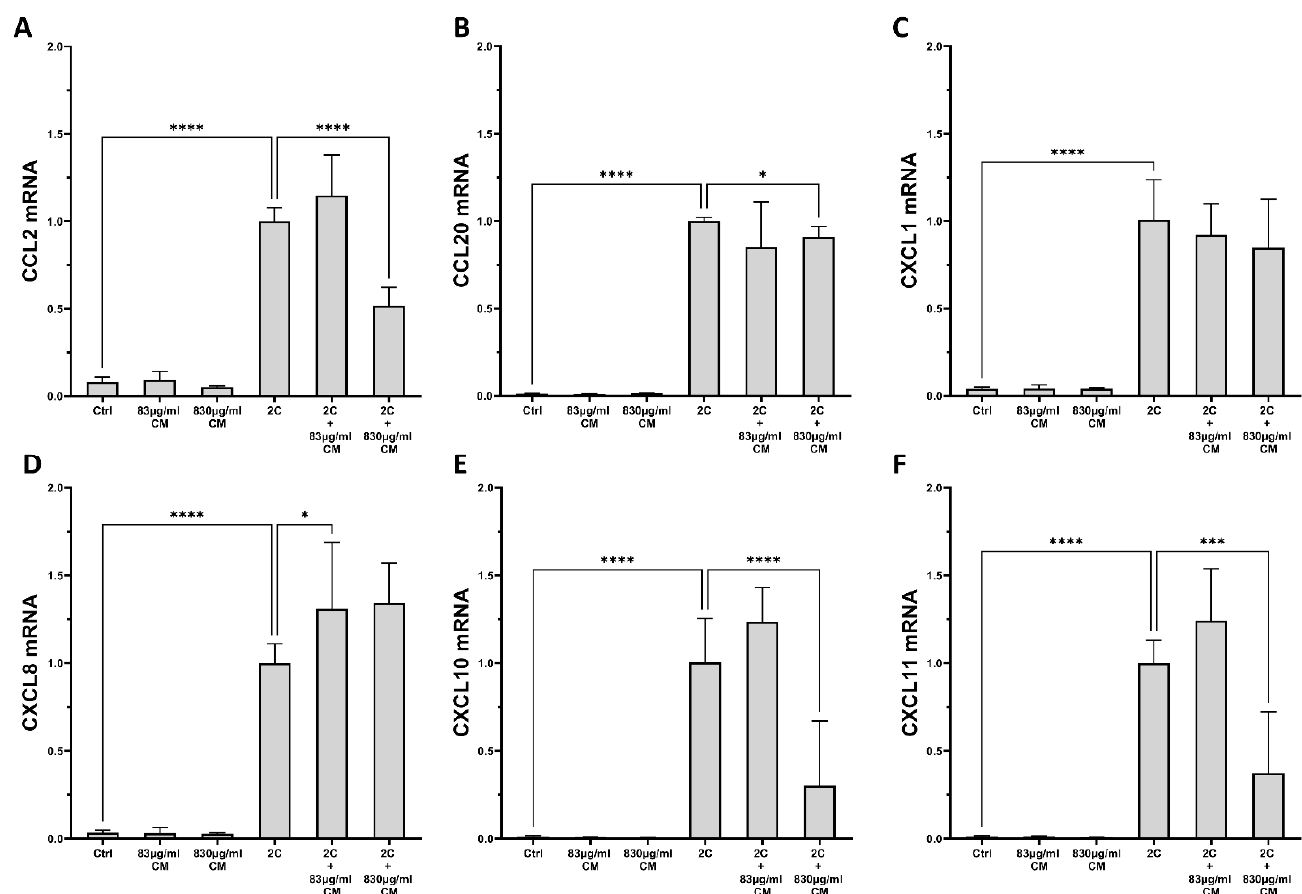
Figure 1. The effect of CM on chemokine mRNA expression in A549 pulmonary epithelial cells, which are under pro-inflammatory stimuli. CM inhibit the mRNA expression of chemokines CCL2 ( A ), CCL20 ( B ), CXCL10 ( E ) and CXCL11 ( F ) in a dose-dependent way, but have no effect on the mRNA levels of CXCL1 ( C ) and CXCL8 ( D ). 2C: IL-1 α 5 ng/mL + TNF- α 50 ng/mL; 830 µ g/mL total protein of CM; 83 µ g/mL total protein of CM. Results are presented as median with interquartile range. **** p < 0.0001; *** p < 0.001; * p < 0.05. N = 3.